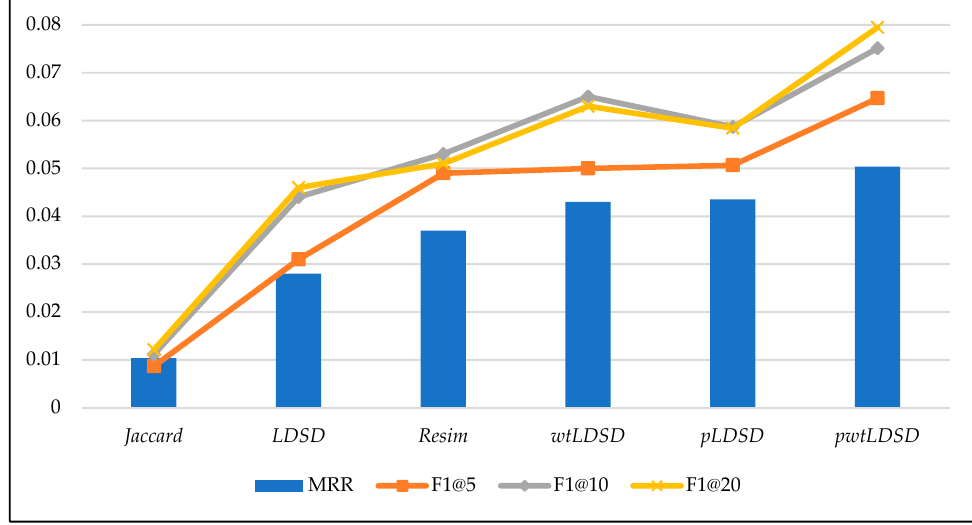
Figure 5. Mean Reciprocal Rank (MRR) scores and F 1 scores at different ranked results cutoffs.